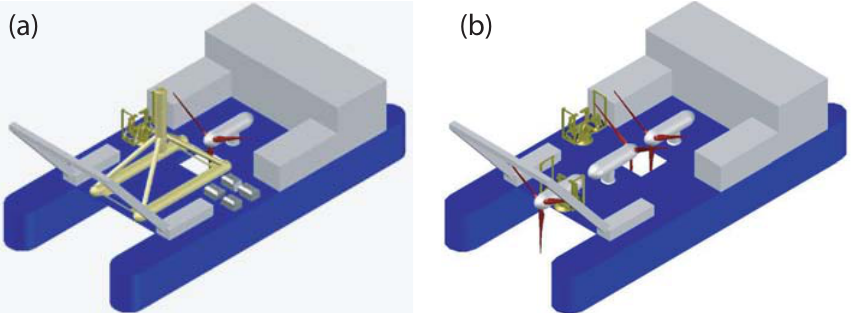
Figure 7. ( a ) HF4 installation vessel transporting the equipment needed to install the TEC; ( b ) HF4 installation vessel transporting nacelles.